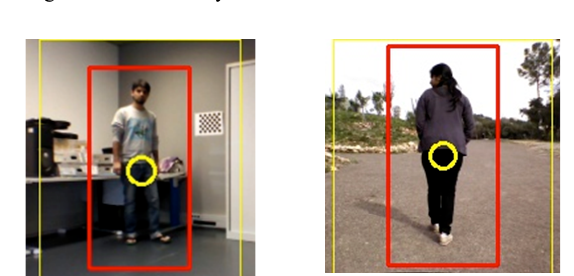
Figure 4. Layered organization of modules common to all drones, independently of their type (Câmara,